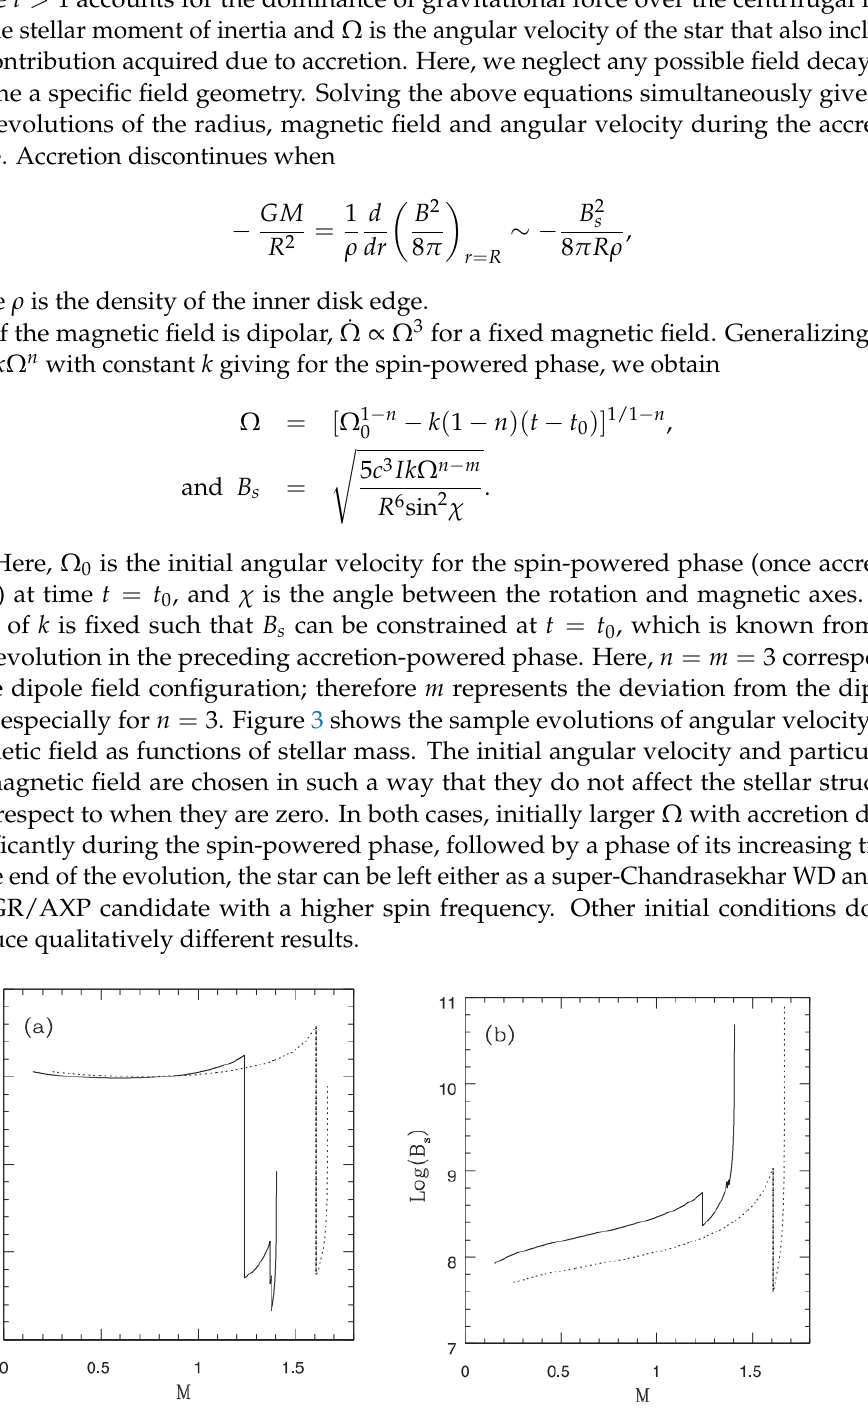
Figure 3. Time evolution of angular velocity (( a ) panel) and magnetic field (( b ) panel) as functions of mass. The solid curves correspond to the case with n = 3, m = 2.7, ρ = 0.05gcm − 3 , l = 1.5 and dotted curves correspond to the case with n = 3, m = 2, ρ = 0.1gcm − 3 , and l = 2.5. The other parameters are fixed with k = 10 − 14 , ˙ M = 10 − 8 M (cid:12) yr − 1 , χ = 10 ◦ and R = 10 4 km at t = 0. See